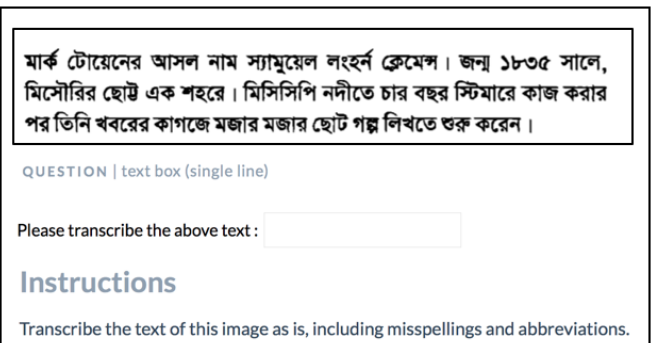
Figure 4. Example of the Bengali transcription task. The digitized image is at the top. Below it is the task